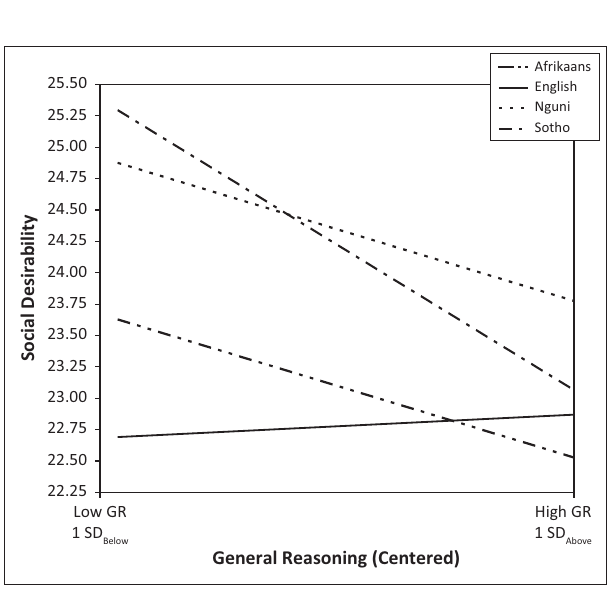
The English group served as the reference group. FIGURE 1: Relationship of general reasoning with social